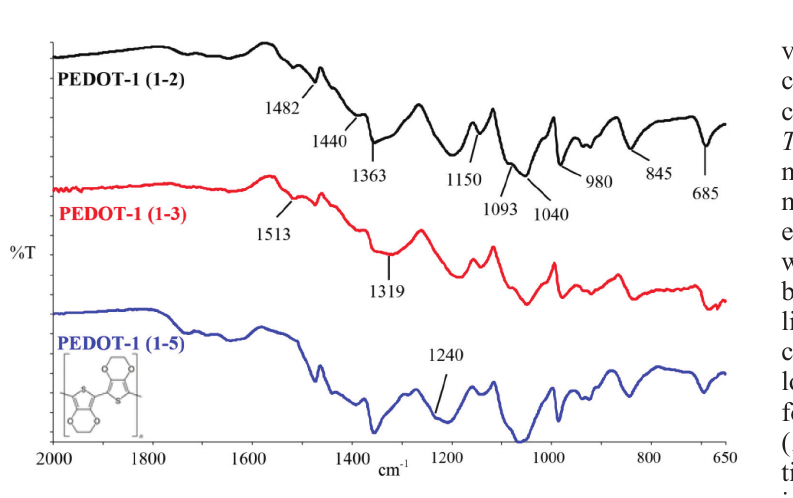
Fig. 1 – FTIR spectrograms of PEDOT samples synthesized by various mono- mer to APS oxidant ratio (1:2, 1:3, 1:5)